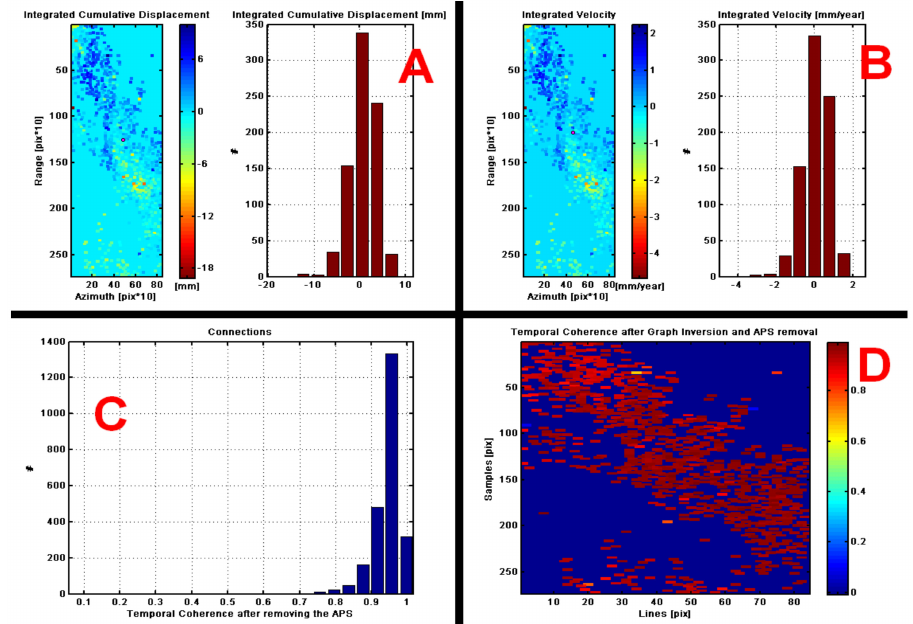
Figure 5. ( A )The plot of integrated cumulative displacement histogram of connections, ( B ) Integrated velocity, ( C ) Histogram and ( D ) Temporal coherence after APS remove.